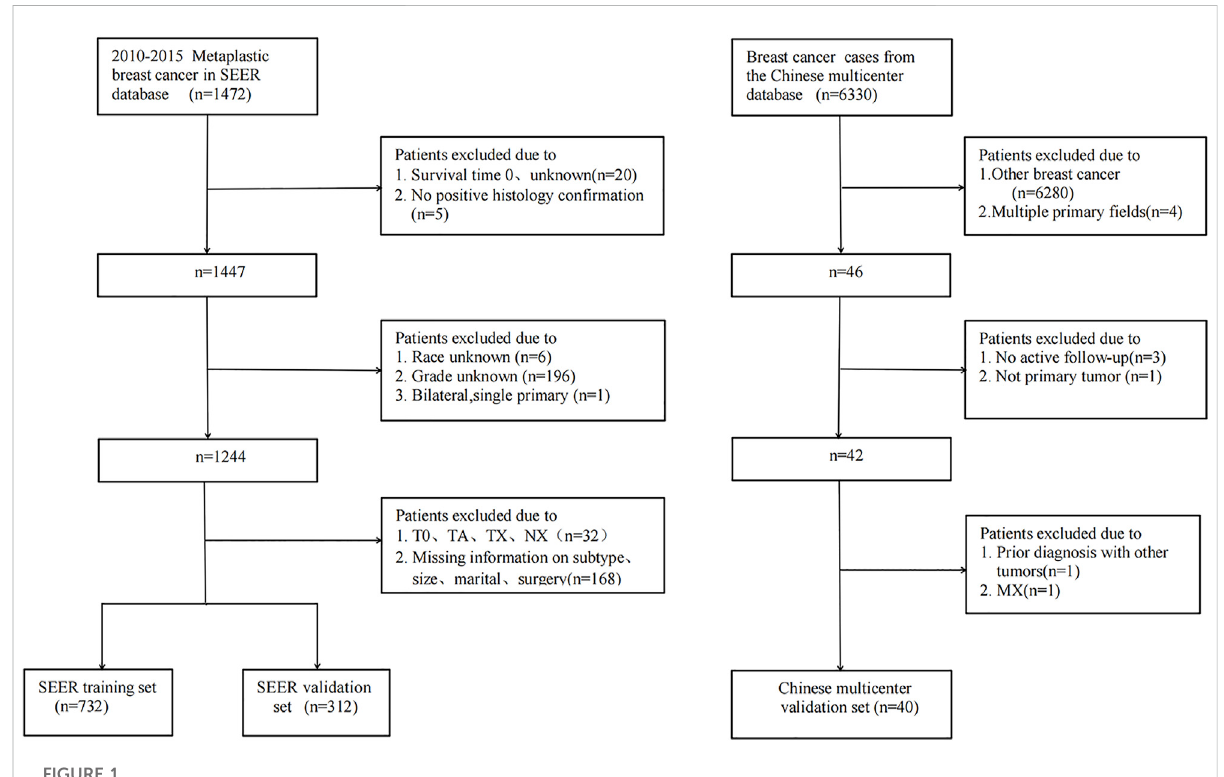
FIGURE 1 Flow diagram of MBC patient selection for the